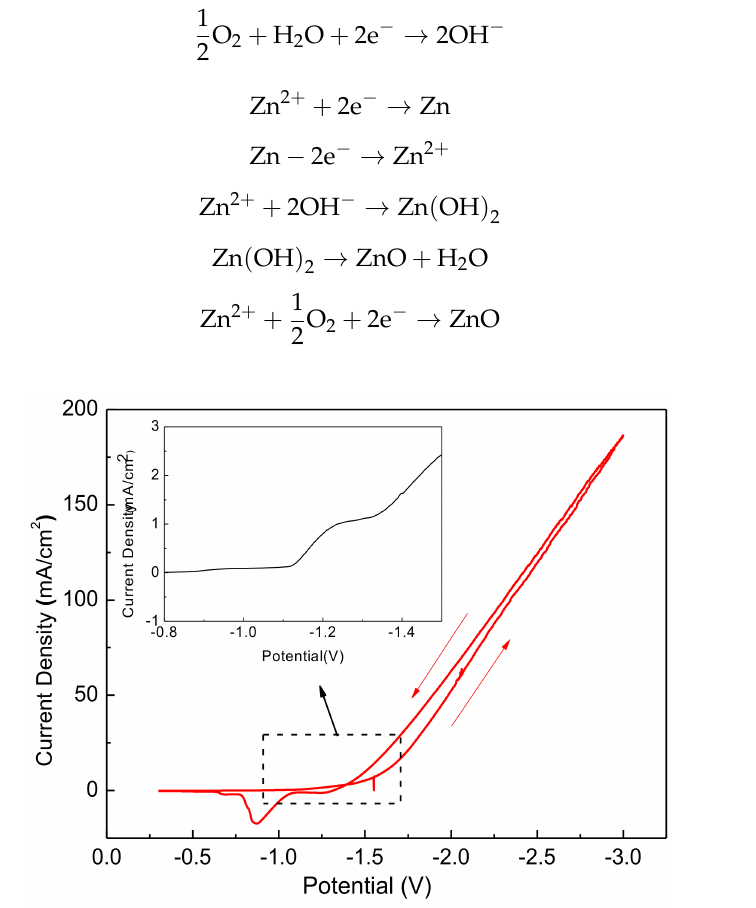
Figure 1. The CV curves of Zn 2+ ions in aqueous solutions with a pH value of